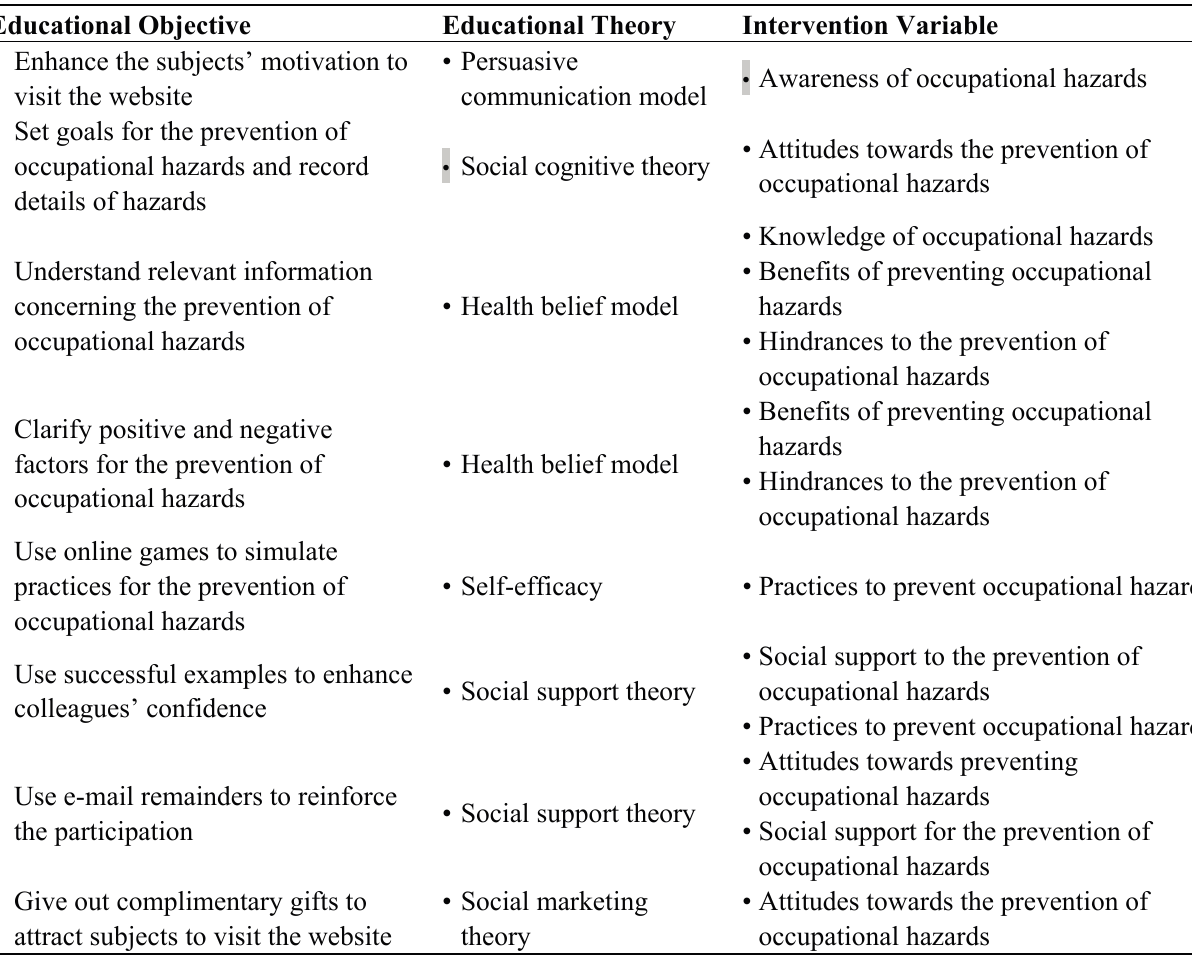
Table 1. Theoretical framework of the website for the prevention of occupational